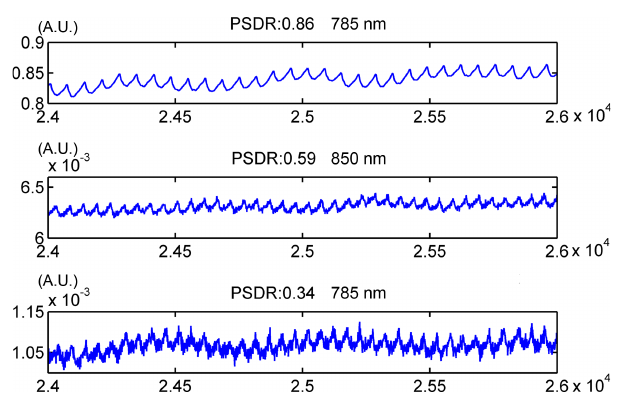
Fig. 2. The original optical intensity over a typical period of time from three subjects with di®erent PSDR. The data in each subgraph is from one channel of one subject. The horizontal axis represents time in points.